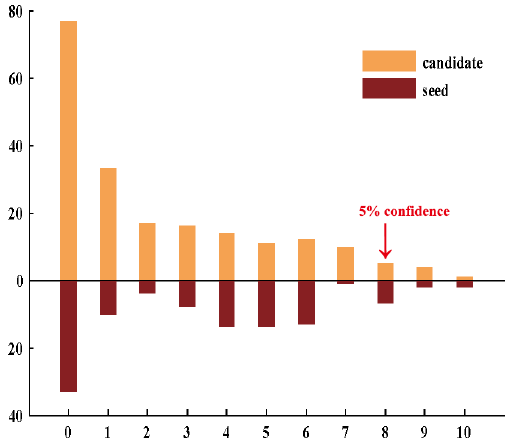
Fig 6. The distribution of the top 200 candidates and seeds among different functional categories. X- axis and y-axis represent the number of the functional categories and enriched genes, respectively.